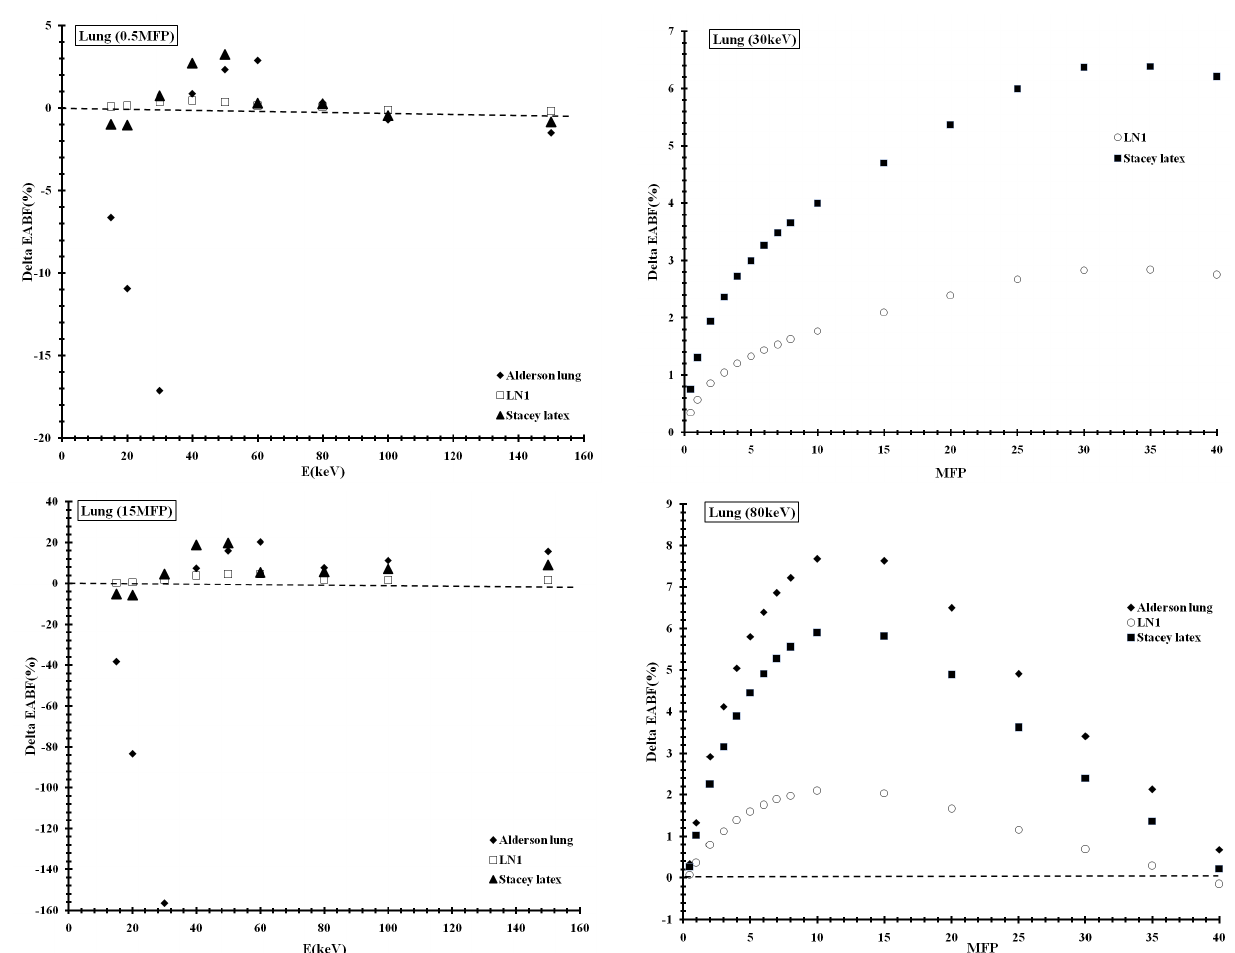
Figure 8. Energy absorption buildup factor for lung tissue as a function of: ( left side) photon energy for fixed depths between 0.5 and 40 mfp and ( right side) depth for fixed photon energy between 15 and 150 keV.